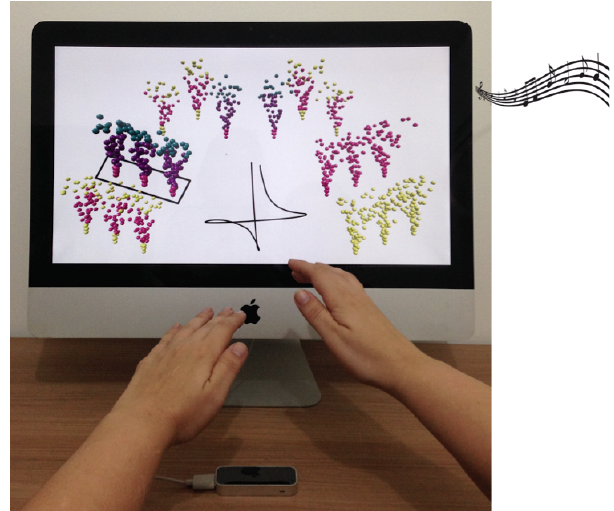
Fig. 3: Illustrative example of a user using the Leap Motion Controller to conduct the particle emitters, in an orchestral arrangement modeled for this